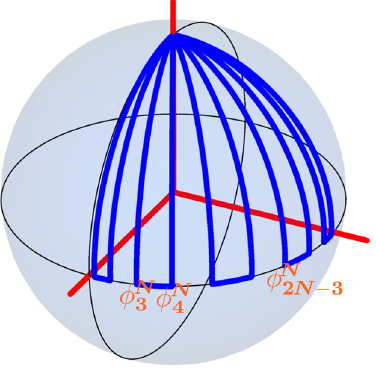
FIG. 4. The vertical snake contour. A proper choice of the turning point ϕ N yields a trajectory covering a solid angle of π = 4 n with an exponentially small error. Here, we plot the contour for the Chebyshev polynomials with N ¼ 5 and ϕ N x N ; n ¼ 1 ; … ; 2 N , are given in Eq. n